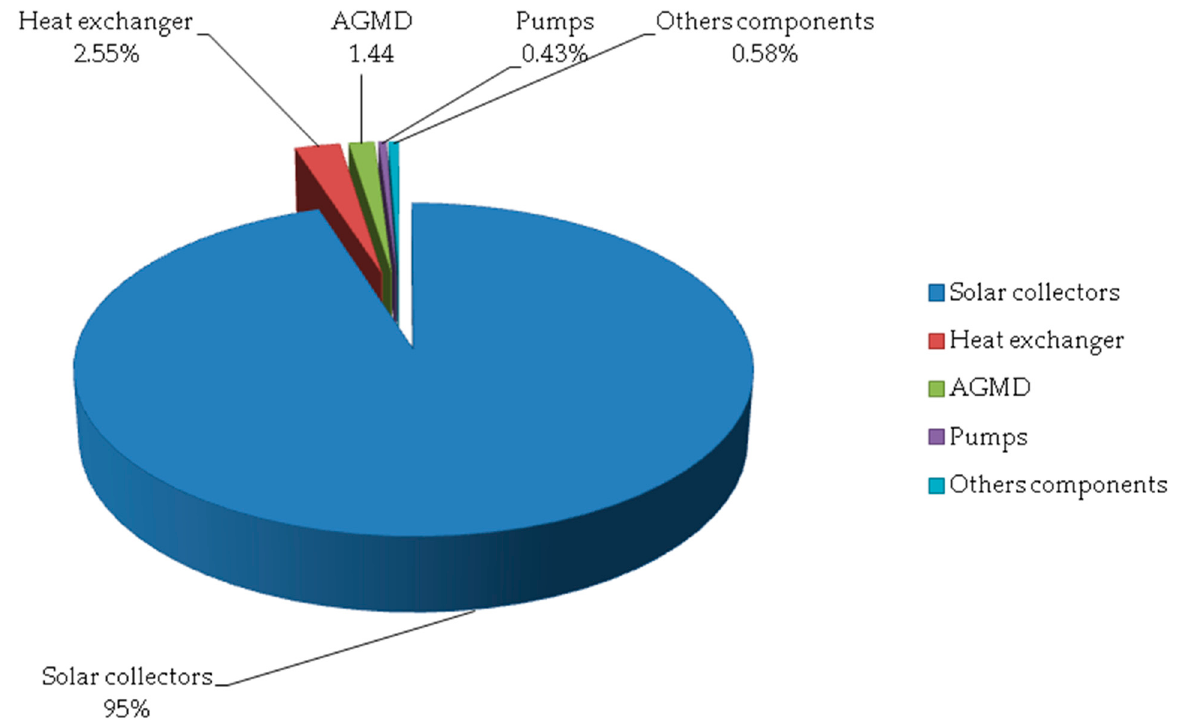
Figure 13. Rates of exergy destruction in the solar AGMD system components.